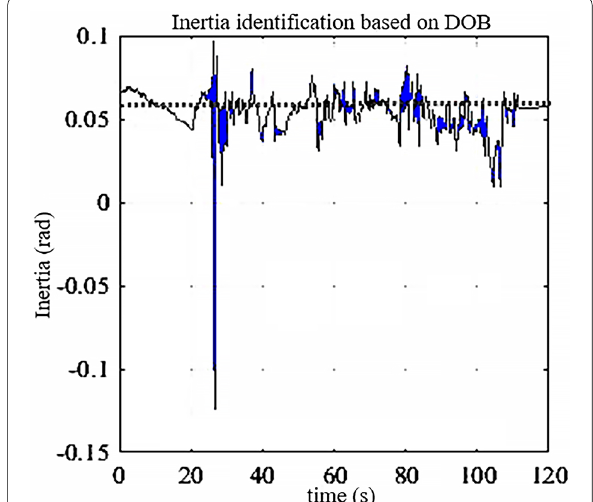
Figure 6 Rotational-inertia identification process